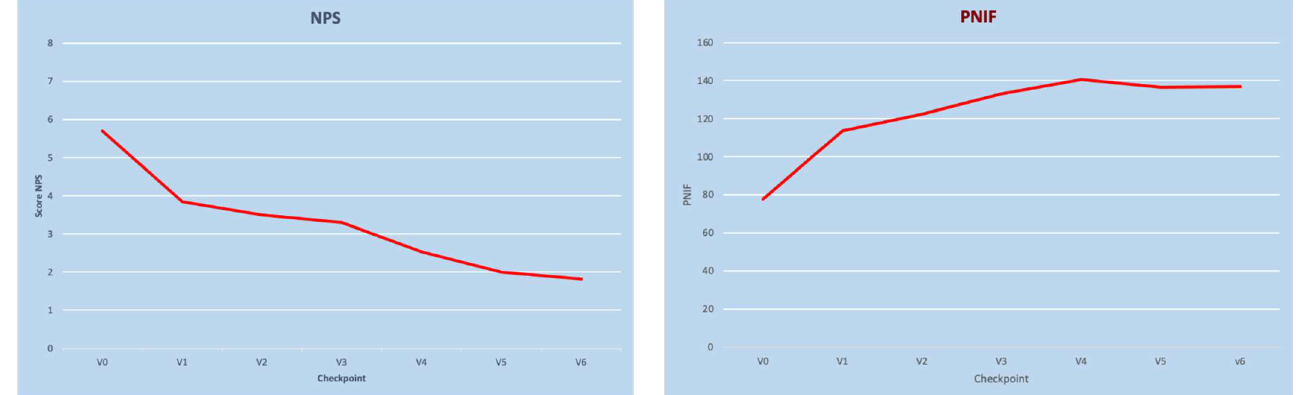
Figure 1. NPS ( left panel ) and PNIF ( right panel ) mean value variations over time. (NPS: nasal polyp score; PNIF: peak nasal inspiratory flow; V0: visit at baseline; V1: 15 days of treatment; V2: 1 month visit; V3: 3-month visit; V4: 6-month visit; V6: 12-month visit).